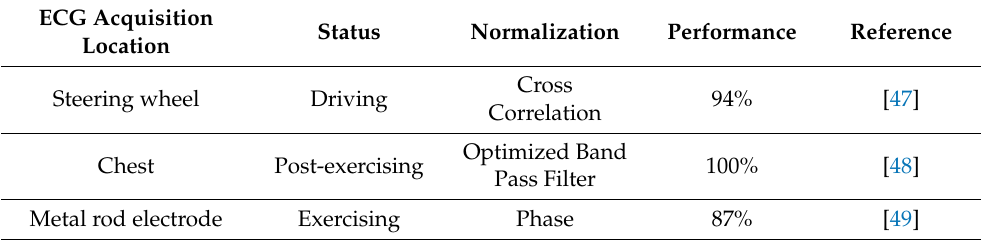
Table 2. Preprocessing: ECG normalization considering driving